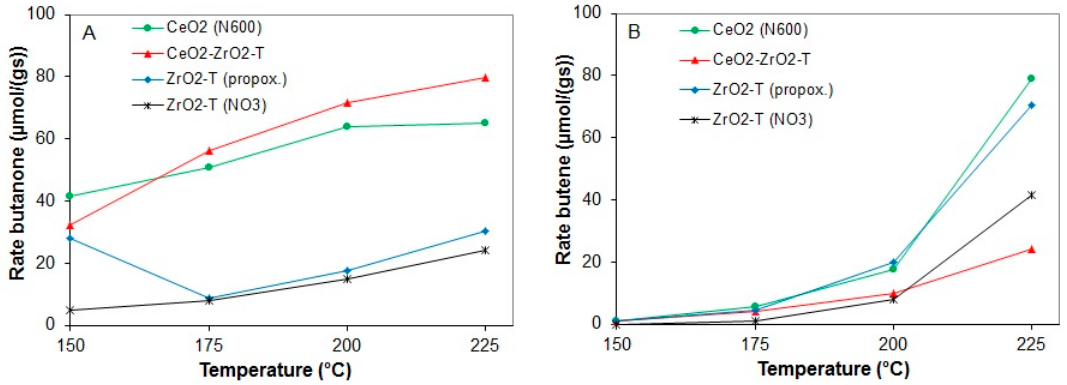
Figure 16. Rates of butanone ( A ) and butene ( B ) from 2-butanol conversion at 150 to 225 °C for various pre-treated catalysts.